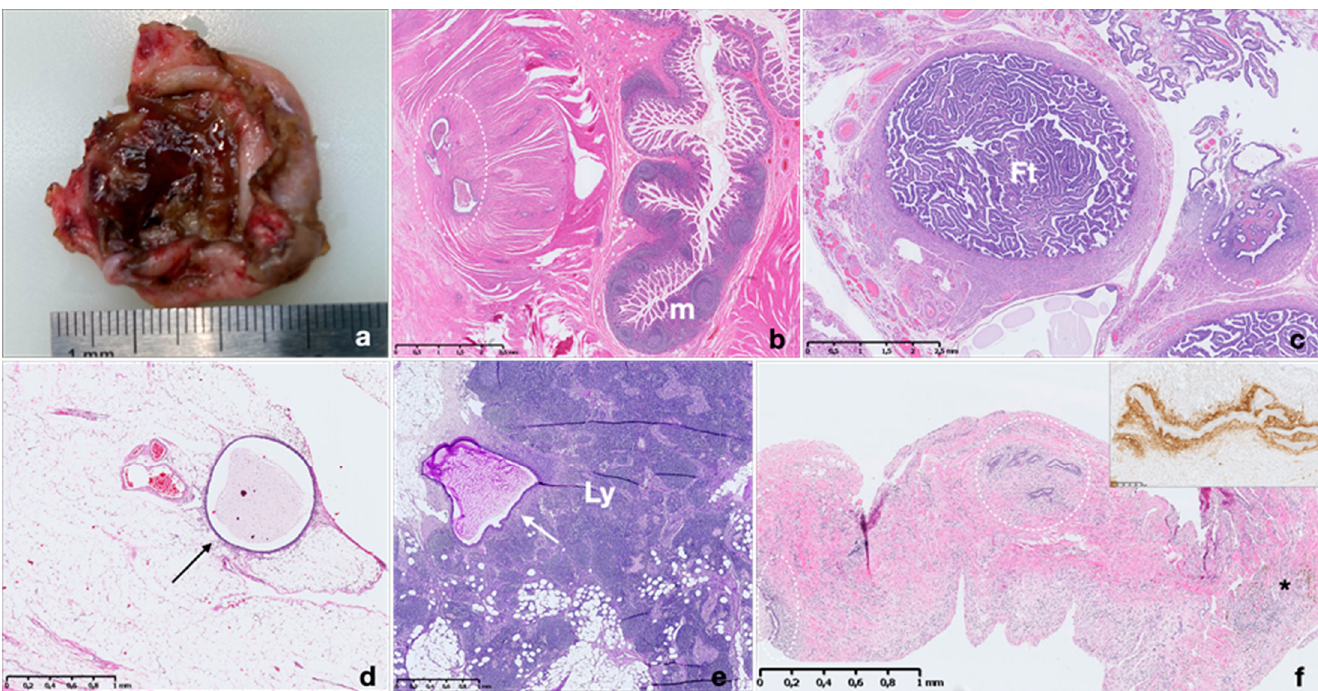
Figure 2. Macroscopic and microscopic appearance of endometriosis in different sites. Macroscopic picture of ovarian endometrioma with fibrotic wall and a dense, dark brown content ( a ). Histopathological images of endometriotic implants in intestinal wall, fallopian tube, mesenteric adipose tissue, lymph node and diaphragm ( b – f ); m: intestinal mucosa; Ft: Fallopian tube; Ly: lymph node. The withe circles and the arrows highlight endometrial implants composed by several endometrial glands and stroma ( b – f ). Note the presence of hemosiderin-laden macrophages (asterisk) ( f ). Immunohisto- chemistry for CD10 shows strong expression in stroma surrounding an ectopic endometrial gland in the diaphragm ( f inset). Hematoxylin and eosin stain.